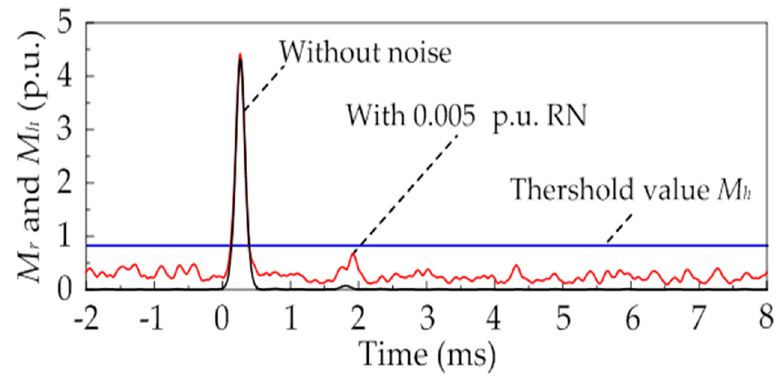
Figure 12. The curve of M 1 with 0.005p.u. of random noise (RN) for the PG fault 50 km from the rectifier-terminal with a resistance of 500 Ω .